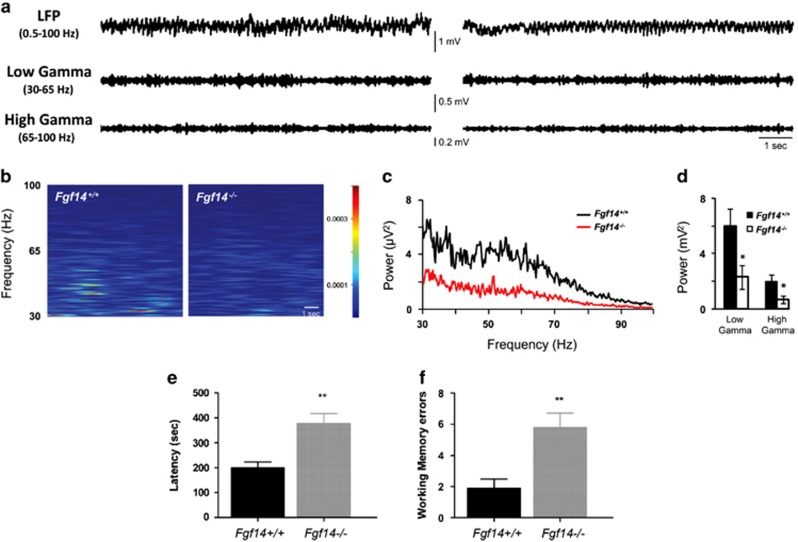
Genetic deletion of Fgf14 reduces gamma frequency and affects working memory. (a) Representative traces of 10-s in vivo electroencephalogram recordings in the CA1 region of hippocampus (local field potential; LFP) in Fgf14+/+ (left) and Fgf14−/− mice (right); filtered traces within low- and high-gamma band are also shown. (b) Spectrogram analysis of the above-mentioned traces in the gamma range (30–100 Hz). (c) Mean power spectral density of CA1 activity showing a marked decrease in gamma power in Fgf14−/− (n=7) with respect to Fgf14+/+ (n=7) mice, as revealed by power analysis within both low- and high gamma (d). (e) Fgf14−/− mice required a longer time to perform the eight-arm maze test (n=20 wild type and n=19 Fgf14−/−; P<0.001, t-test). (f) Analysis of working memory errors committed during the test day showed a significant difference between genotypes (P<0.05, t-test). Data are expressed as mean±s.e.m. *P<0.05.